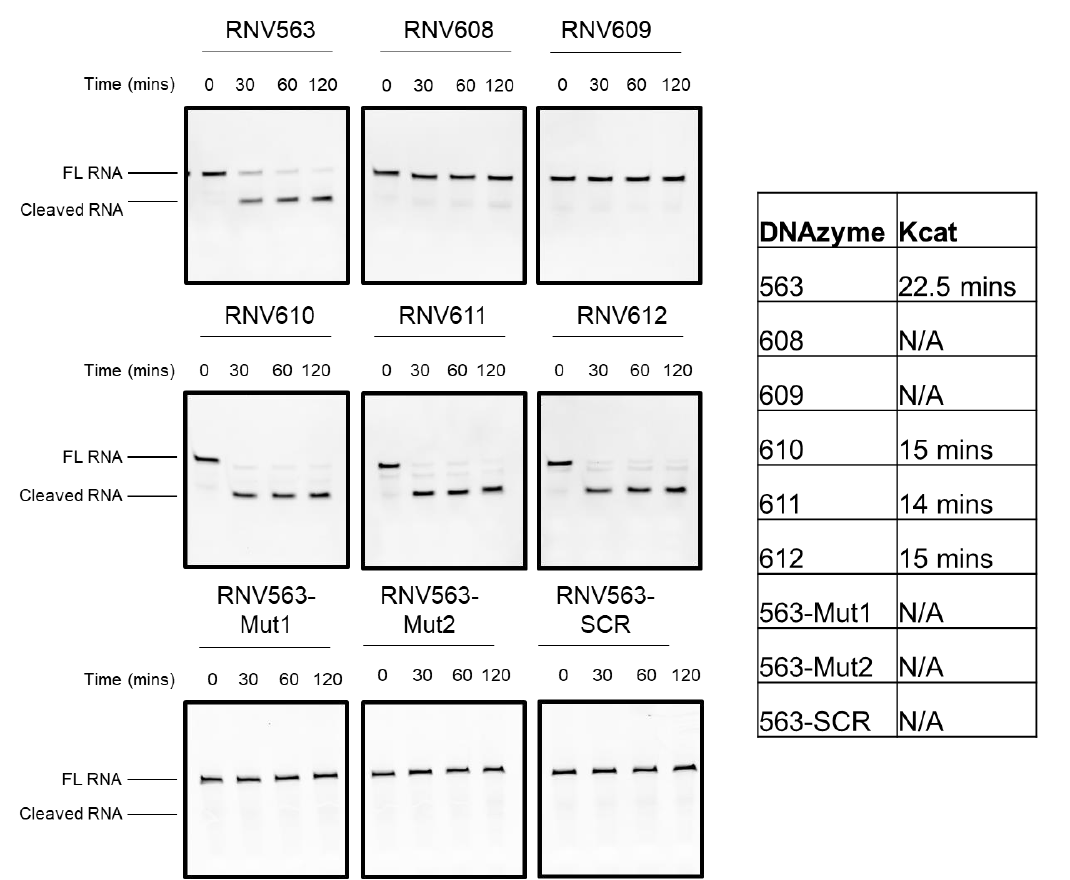
Figure 3. In vitro cleavage of the synthetic fluorescein dye (FAM)-conjugated MAPT RNA template by RNV563 and its derivatives. The table provides the catalytic activity. FL RNA, full-length FAM- conjugated RNA; cleaved RNA, cleaved FAM-conjugated MAPT RNA (22 nucleotides long). The FAM-conjugated template RNA is a small region of the MAPT transcript complementary to the hybridization arms of the DNAzymes. The gel images were cropped for a better overview. The original images are shown in Figure S4 (Supplementary